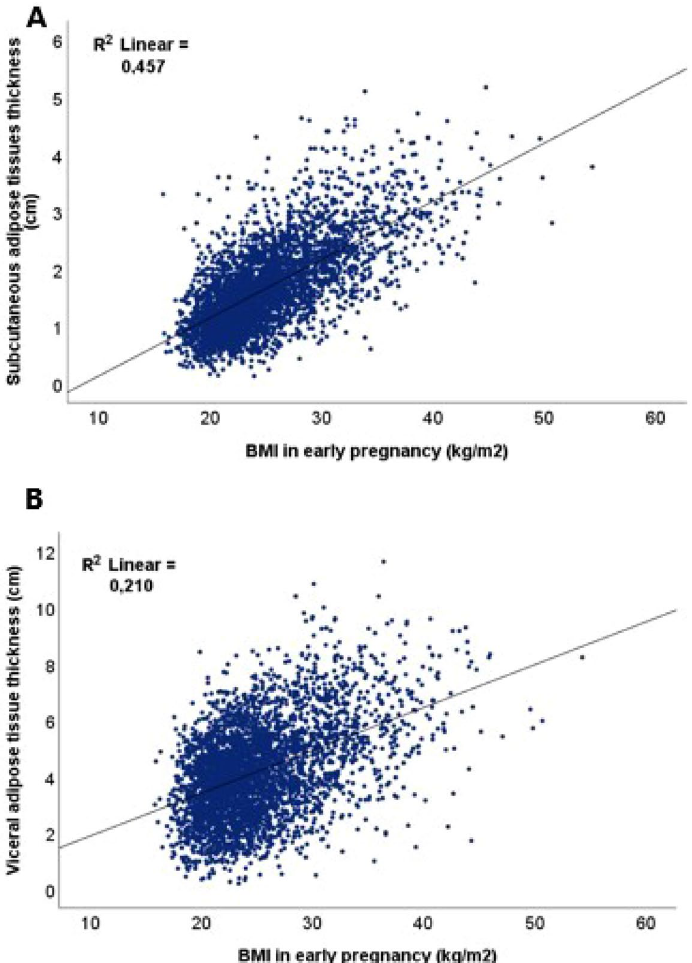
Figure 3. Correlation between body mass index (BMI) and subcutaneous adipose tissue (SAT) thickness ( A ) and visceral adipose tissue (VAT) thicknesses ( B ).